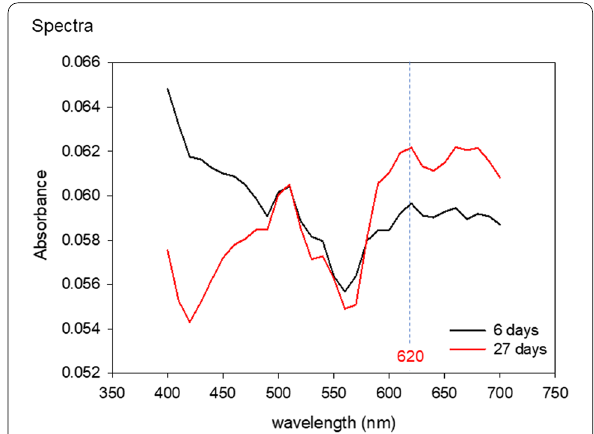
Fig. 5 Spectra of early and later cultures of periosteal sheets. These spectra are representative of four pairs of independent cultures